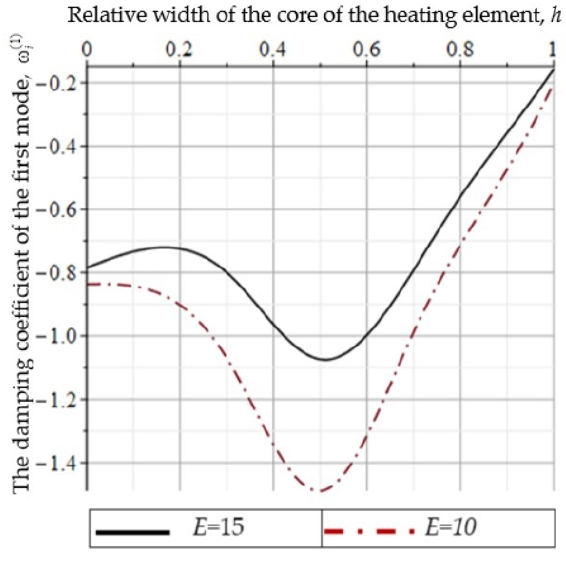
( 1 ) on h at various values of drawing ratio E ω on h at various values of drawing ratio Е . i i